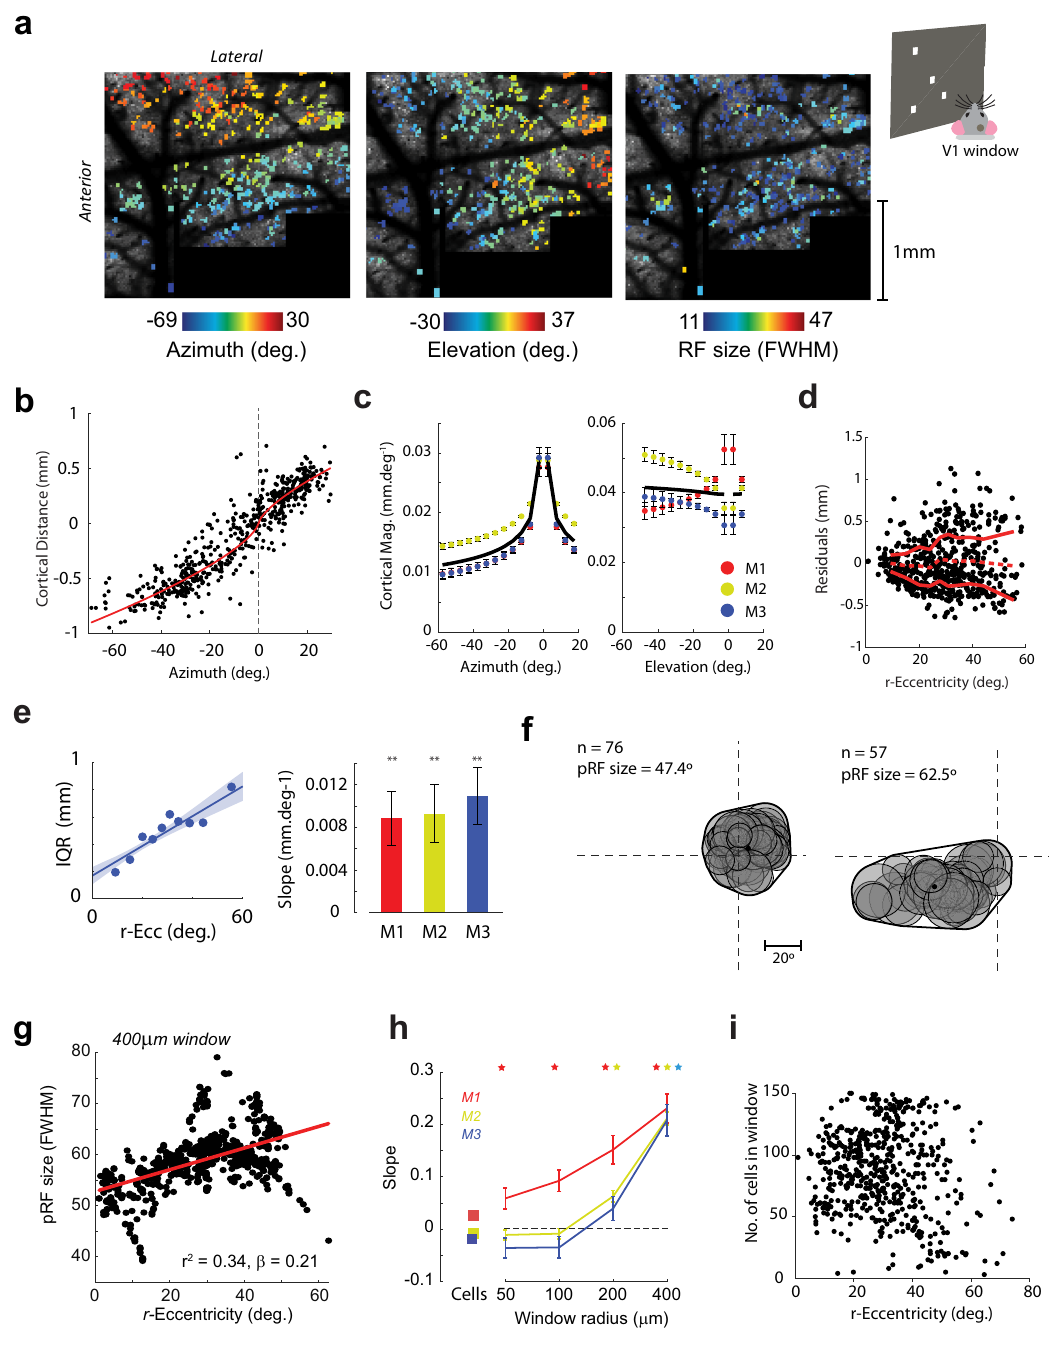
fi xed foceal projection had a different position than the un fi xed projection in all three behavior types (paired t -test, all p <